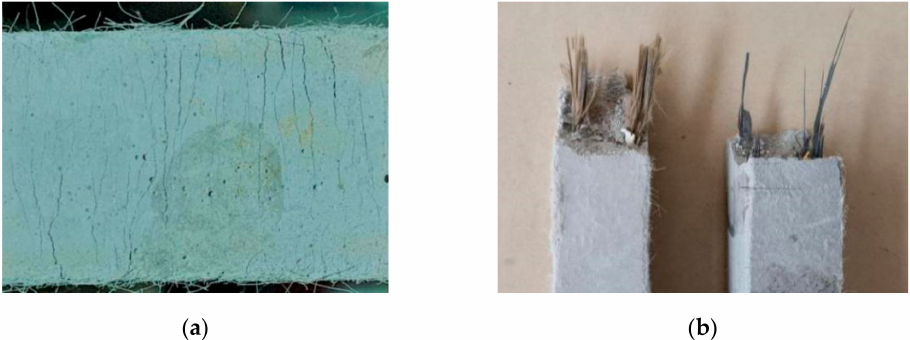
Figure 4. Specimen tensile damage pattern. ( a ) Multi-crack development characteristics of specimen surface, ( b ) FRP grid-reinforced ECC specimen